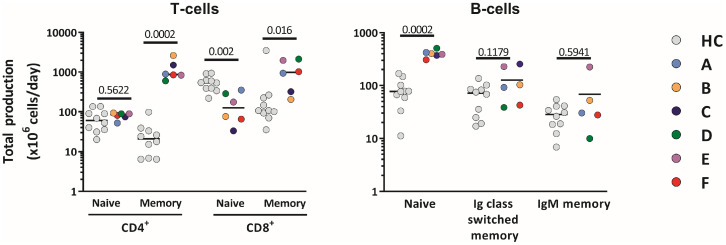
Total daily production of T- and B-cell subsets, calculated as average production rate (σN +pN )× (absolute number of cells per liter of blood) × (five liter blood) × 50, assuming that 2% of lymphocytes reside in the blood (Ponchel et al., 2011).Horizontal lines represent median values. p-values of differences between groups are shown (Mann–Whitney test).